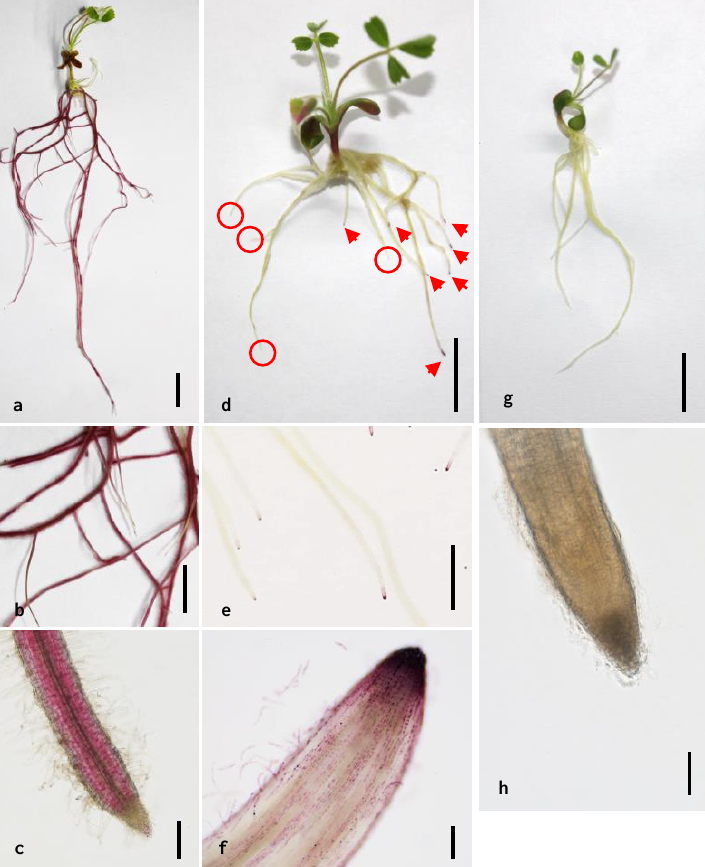
Figure 1. Anthocyanin markers allow the easy visual screening of transgenic roots in M. truncatula . ( a – c ) Purple coloration caused by anthocyanin accumulation can be observed in the root endodermis and pericycle after transformation with pAtE47-MtLAP1 (A17 plant grown on MFP medium for 18 days); ( d – f ) Strong coloration of the root tips (red arrows) observed after transformation with pMtRC-MtLAP1 allow transgenic roots to be easily distinguished from non-transgenic roots (circles) by the naked eye (A17 plant growing on MFP medium for 14 days); ( g , h ) No coloration was seen in the root tips after transformation with pAtUbi10-DsRed (A17 plant grown on MFP medium for 16 days). Bars are 10 mm ( a , d , g ), 5 mm ( b , e ), 200 µm ( c , f ), and 100 µm ( h ).